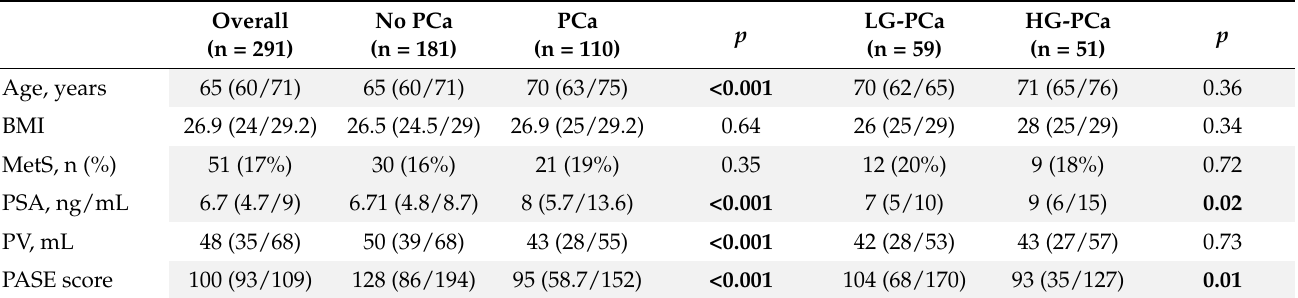
Table 1. Patients characteristics according to PCa diagnosis and high-grade